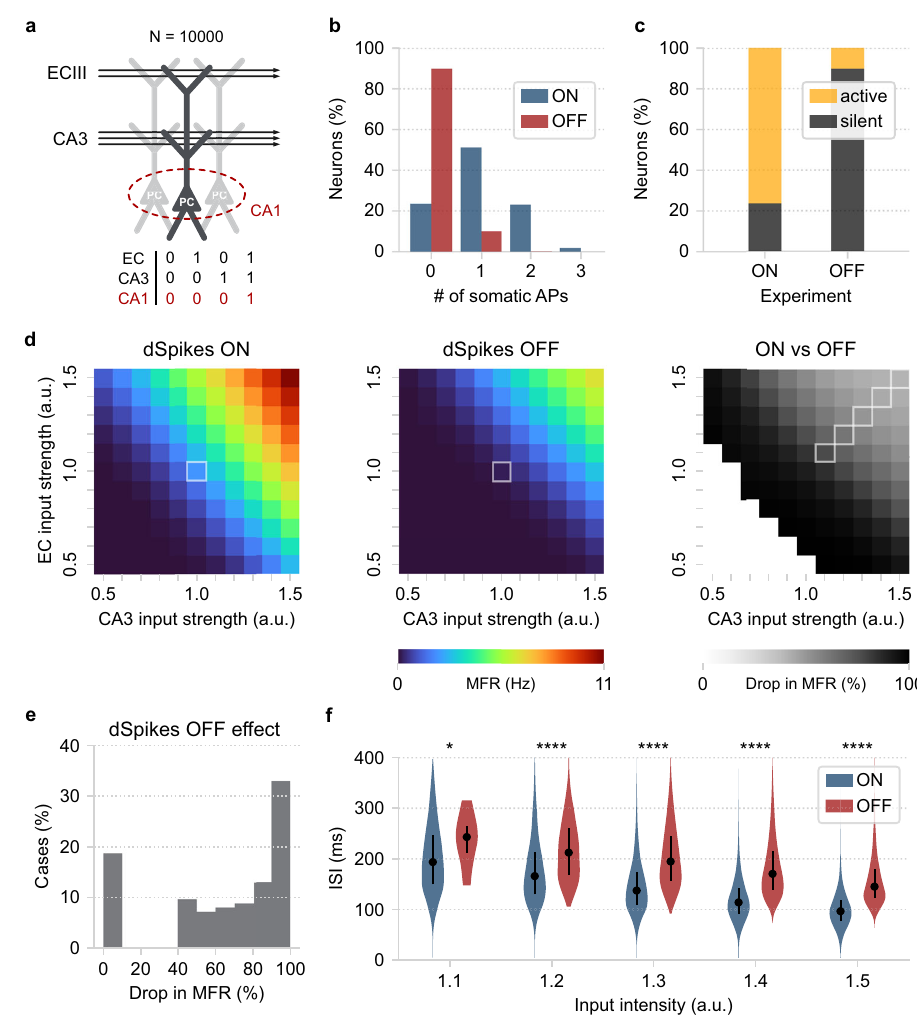
Fig. 5 | Pathway interaction in a reduced CA1 network model. a Schematic illustration of a pool of reduced compartmental CA1 PCs ( N =10,000). The arrows represent the two streams of input (independent Poisson-distributed spike trains) projecting to distinct dendritic segments. Each neuron represents a repetition of the same experiment with independent Poisson-distributed inputs of the same average frequency. Bottom: table describing the conditional activation of CA1 PCs requiring coincident EC and CA3 input. b Probability distribution of somatic spike count, with (ON) or without (OFF)dendritic spikes, when both ECand CA3 input is applied to the network. c Summary of the results shown in panel ( b ). Active neu- rons: PCsthat fi red ≥ 1 somaticspike. Noticethe reductionofthe active population size when dendritic spiking is turned off. d Repeating the coincidence detection experiment for a broad range of input intensities. Left: Mean neuronal firing rate (MFR) for each combination of EC/CA3 input amplitudes. Centre: same as in Left but with dSpikes turned off. The highlighted squares indicate the initial